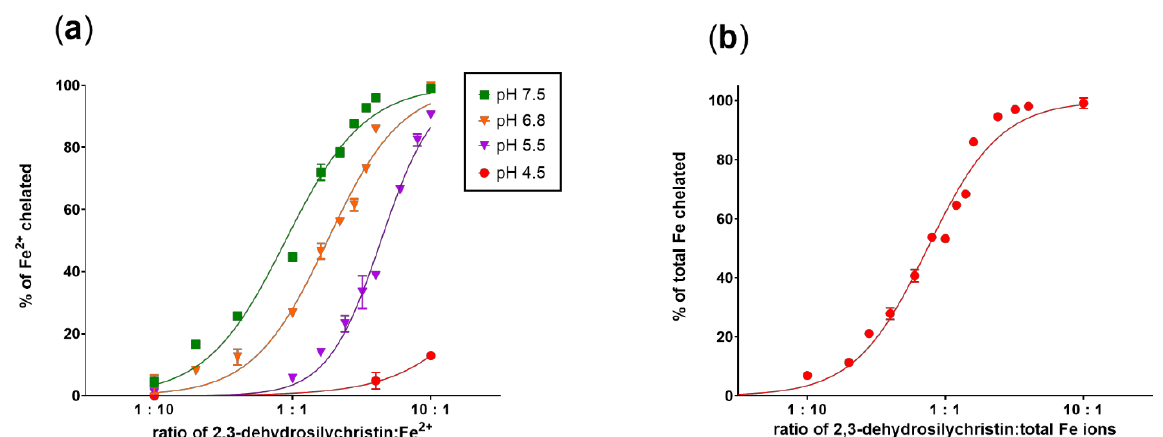
Figure 4. Iron-chelating properties of 2,3-dehydrosilychristin: ( a ) chelation of Fe 2+ ; ( b ) total iron chelation. Data depict measurement after 5 minutes.